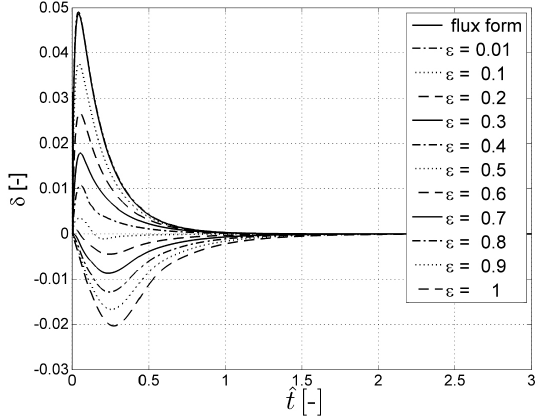
Figure 3. Aggradation case: variation in time of the dimensionless concavity parameter δ in the case of the flux formulation, and in the cases of the entrainment formulation for di ff erent values of ε ranging from 0.01 to 1. The result for the flux form overlaps with the result for the entrainment form with ε = 0 . 01. Note the reversal in behavior as ε increases beyond about 0.5.